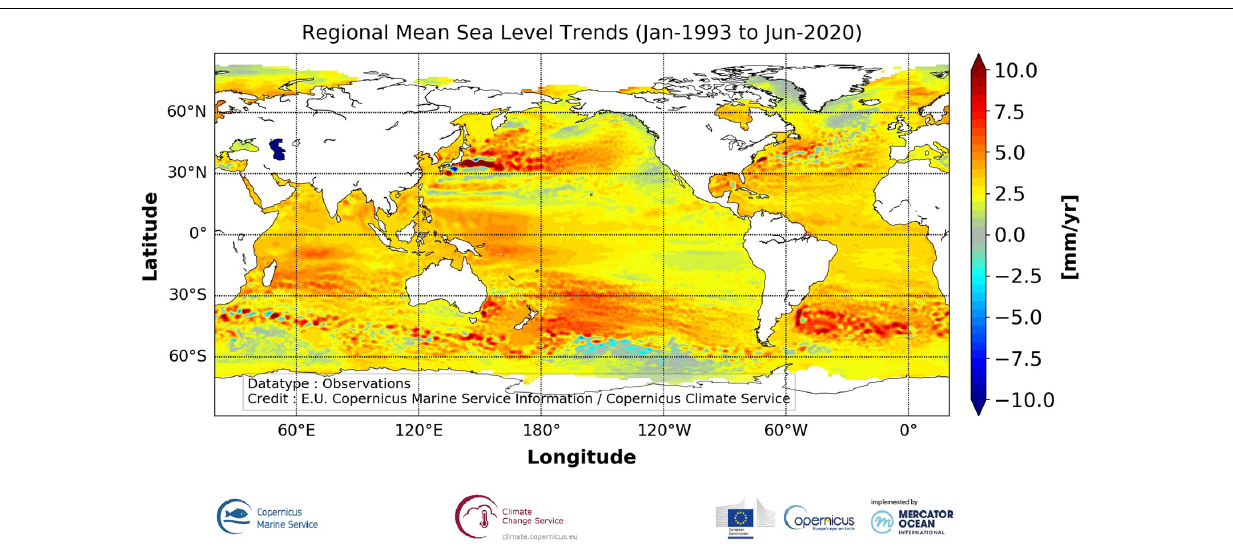
FIGURE 8 | Regional distribution of the trends of the satellite altimeter sea level observations (in mm/yr) from January 1993 to June 2020. The trends are derived from the altimeter C3S multi-mission gridded sea level product (DUACS vDT2018). The trends are not corrected for the TOPEX-A instrumental drift nor for the GIA